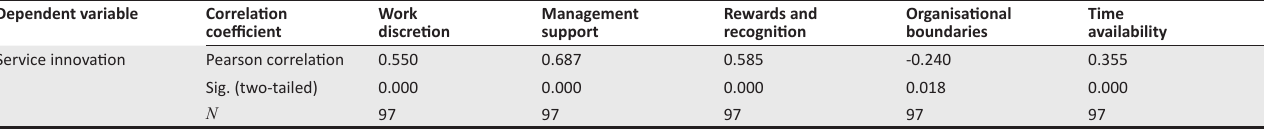
TABLE 4: Pearson’s correlation coefficient. Dependent variable